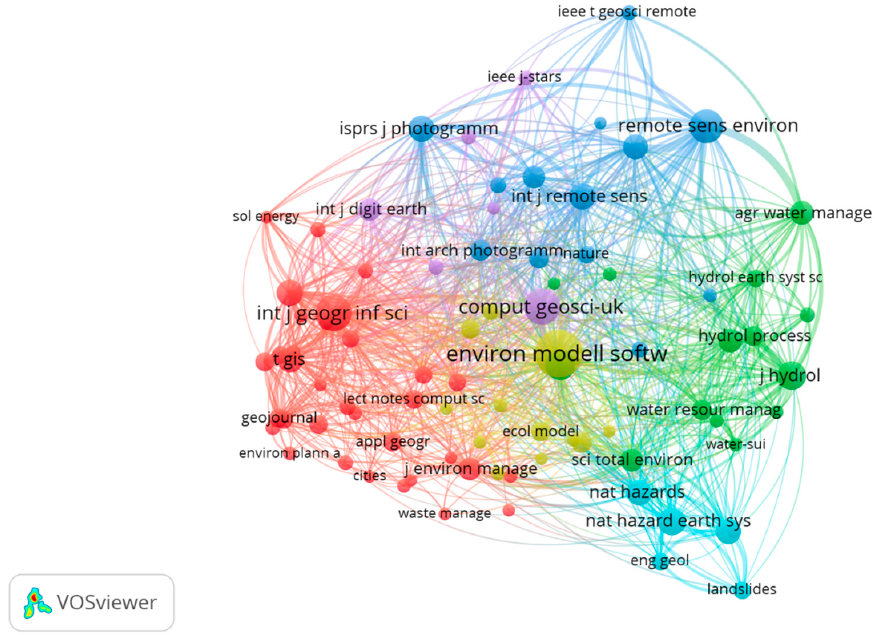
Figure 2 The network of co-citation (cited resources) relations in WoS database. Figure 2. The network of co-citation (cited resources) relations in WoS database.